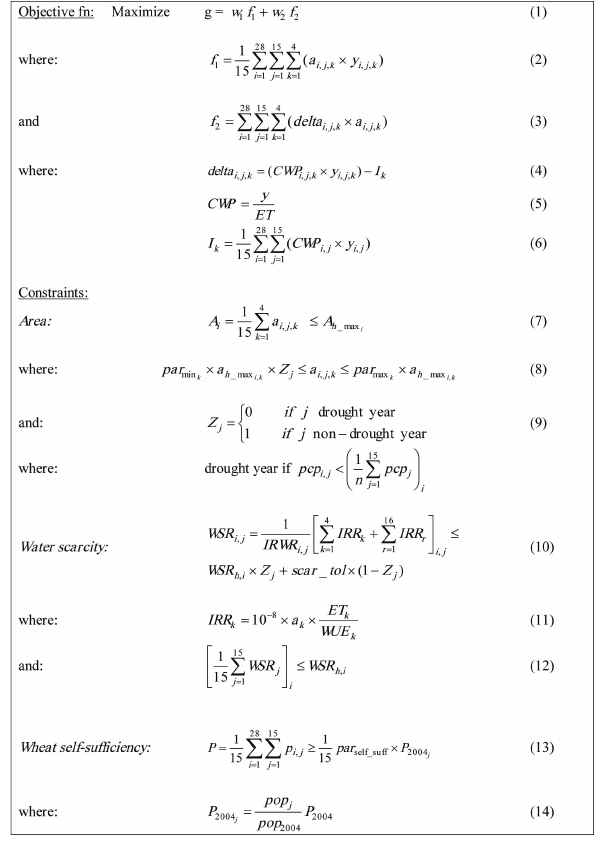
Fig. 2. Construction of the LP model for adjustment of the structure of cropping